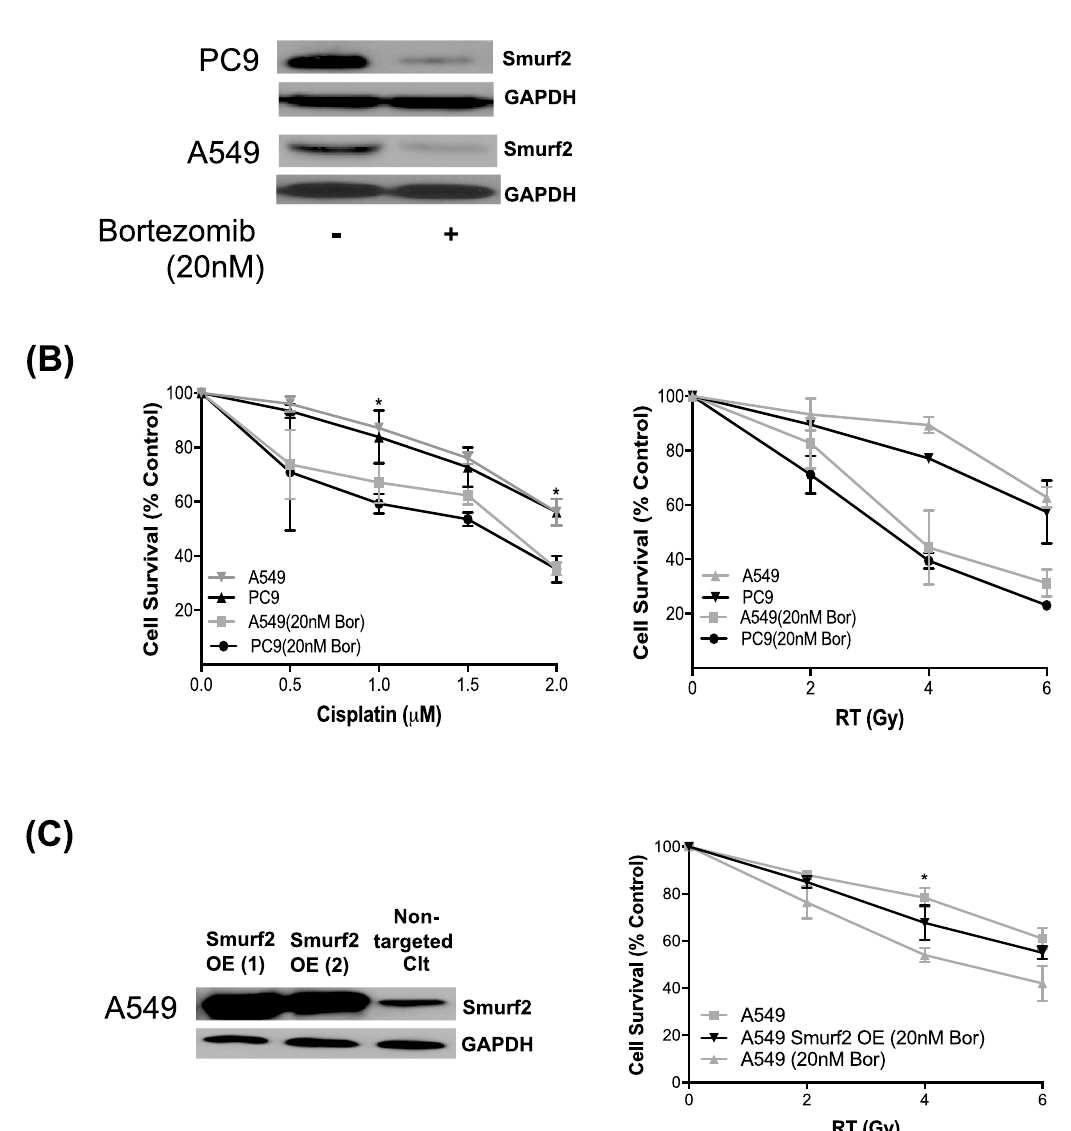
Figure 2. Clonogenic survival analysis and Smurf2 expression in bortezomib-treated PC9 and A549 cells. Western blot analysis showed that 20 nM bortezomib reduced Smurf2 protein expression in PC9 and A549 cells ( A ). Combined treatment with bortezomib (20 nM) plus cisplatin and bortezomib (20 nM) plus radiation in PC9 and A549 cells significantly decreased clonogenic survival compared to that of the corresponding cells treated with cisplatin and radiation alone, respectively ( B ). Overexpression of Smurf2 with two separate targeting plasmid constructs in A549 cells (Smurf2 OE 1, 2) compared to wild-type expression of Smurf2 in control A549 cells (nontargeting control). Overexpression of Smurf2 rescued A549 cells from the toxic effects of radiation and bortezomib treatment, as evaluated by clonogenic assays ( C